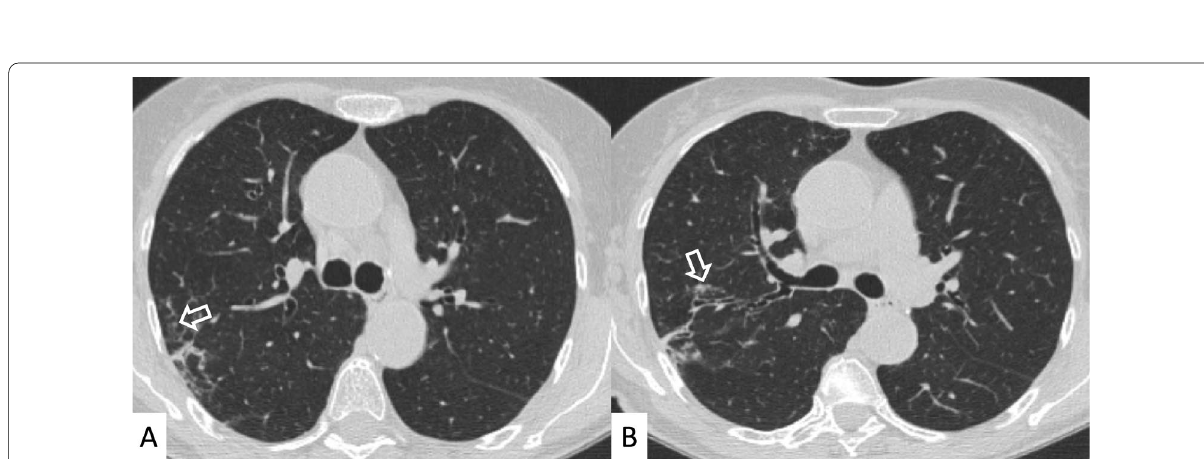
Fig. 24 Pulmonary nodules and reticulations in a pattern LIP. Nodules (white empty arrows in A , B ) may be reproduced in LIP patients, due to the presence of lymphocytic bronchiolitis, with thickening of the bronchovascular